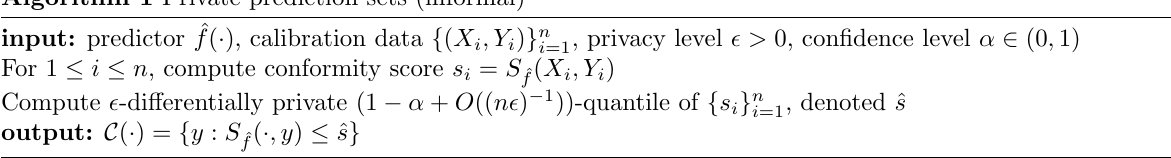
Algorithm 1 Private prediction sets